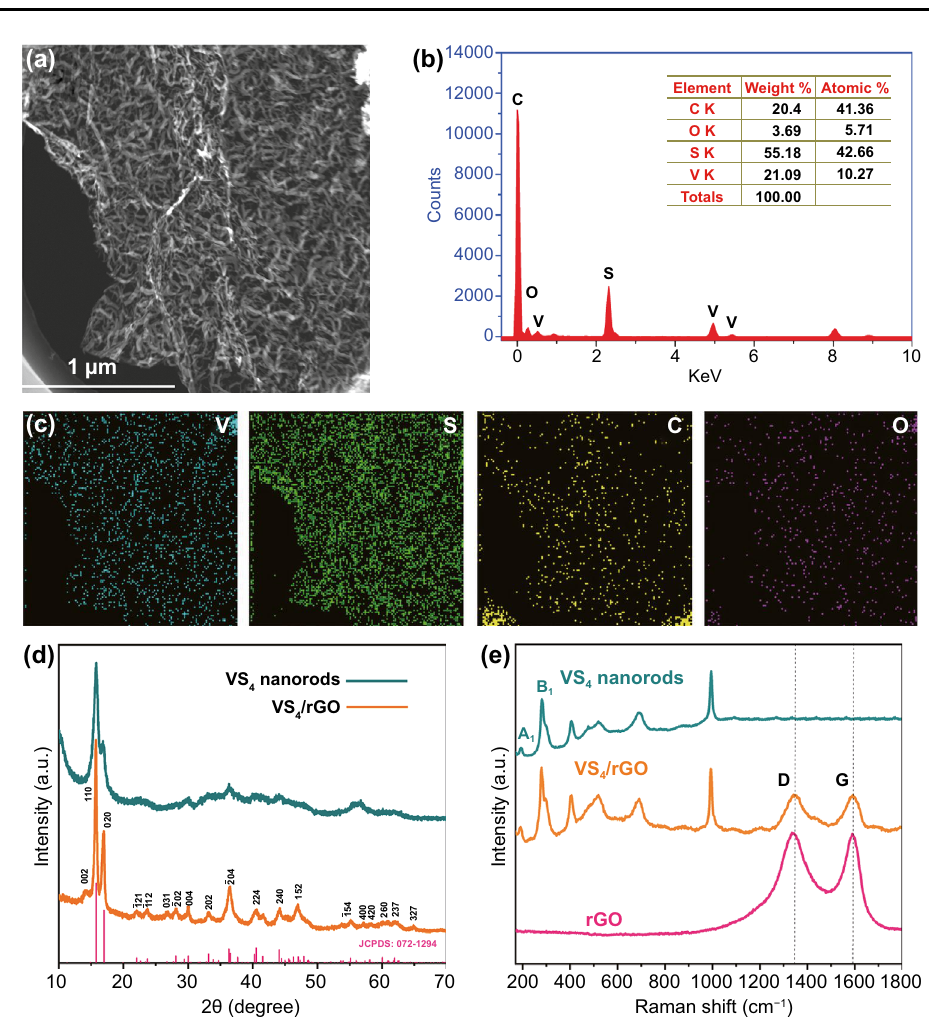
Fig. 2 a TEM image of VS 4 /rGO heterostructure for the EDS mapping. b EDS spectra and the table of elemental composition. c TEM image corresponding to EDS elemental mappings: V, S, C and O. d XRD patterns of VS 4 nanorods and VS 4 /rGO heterostructures. e Raman spectra of VS 4 nanorods, rGO and VS 4 /rGO